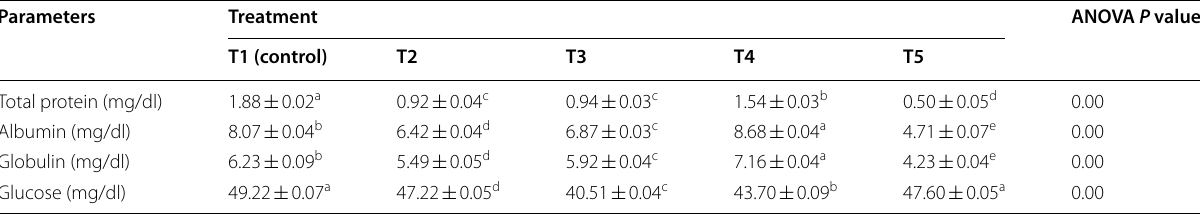
Figures in each column having the same superscripts are not significantly different at P > 0.05 Mean in a given row with the same letter a, b, c, d or e were not significantly different at ( P > 0.05)